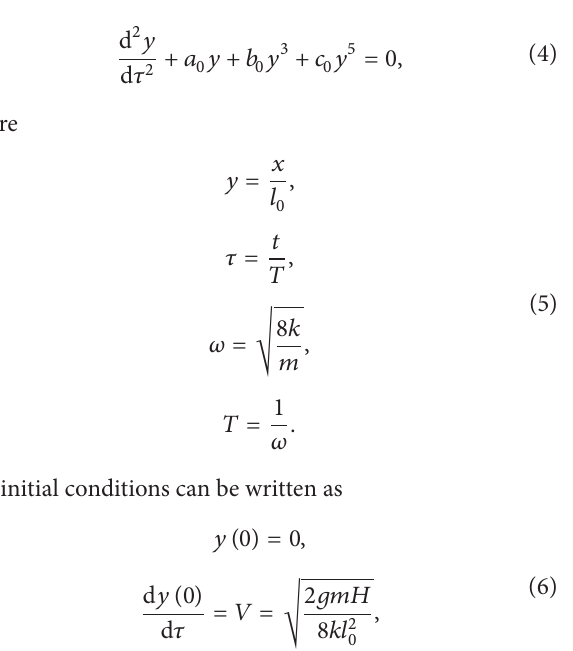
parameters and the damage boundary is suggested. Finally, the dropping damage boundary curves and surfaces of the system are discussed according to the damage evaluation